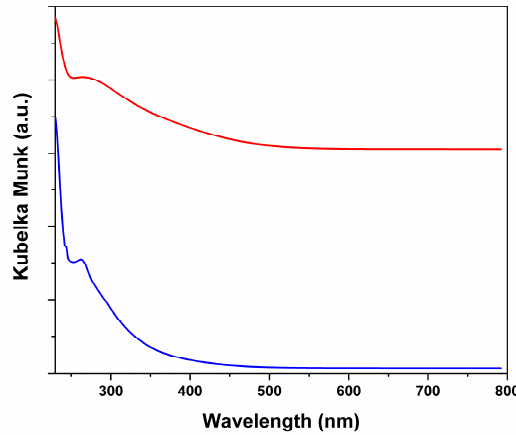
Figure 2. UV ‐ Vis diffuse reflectance (UV ‐ Vis ‐ DR) spectra of samples Cu_5.2 wt %_SiO 2 _PB (blue line) and Cu_7.7 wt %_SiO 2 _PB (red line). and Cu_7.7 wt %_SiO 2 _PB (red